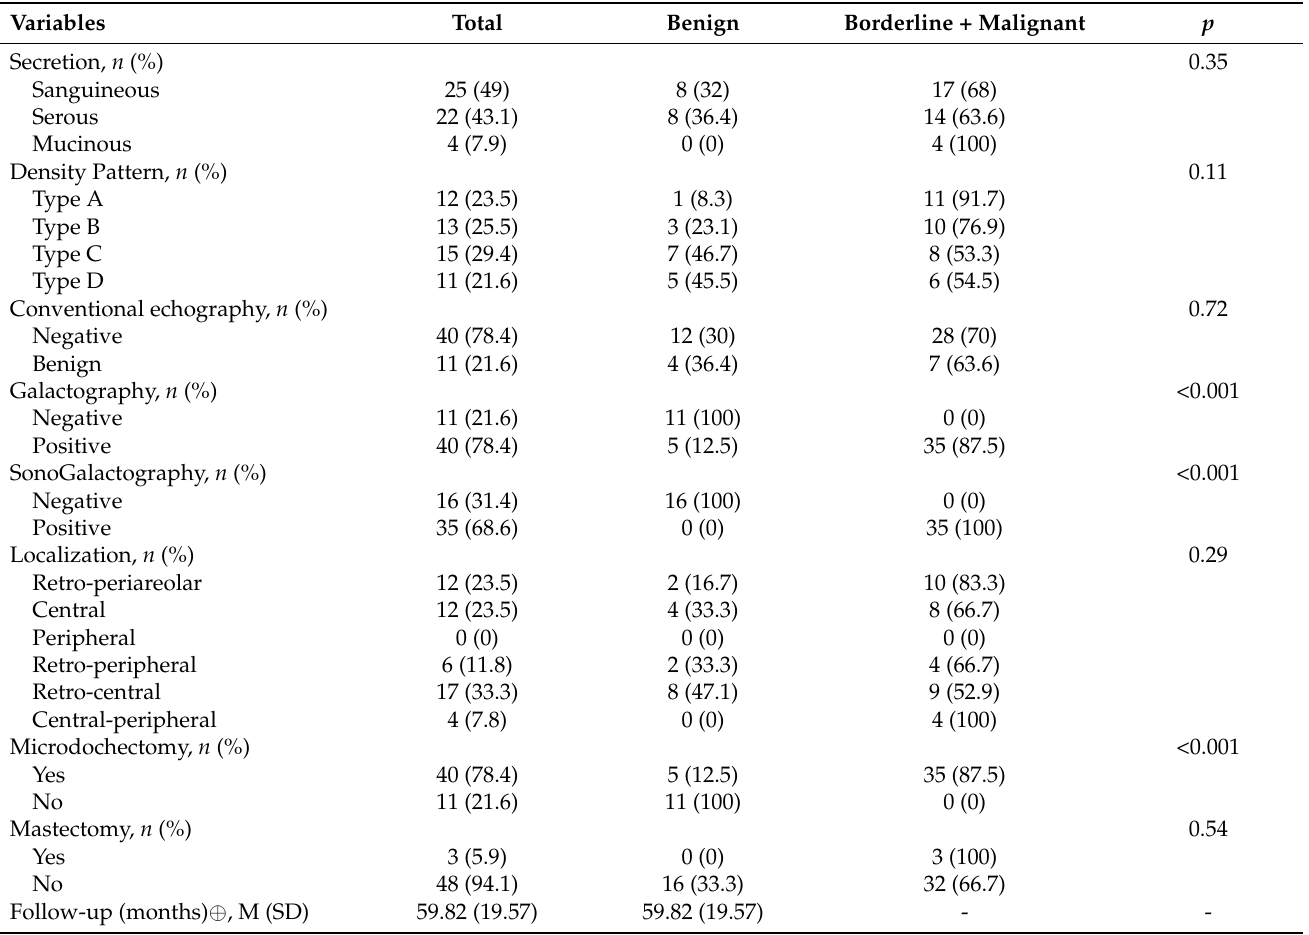
Table 2. Association between the results of the imaging tests and pathological